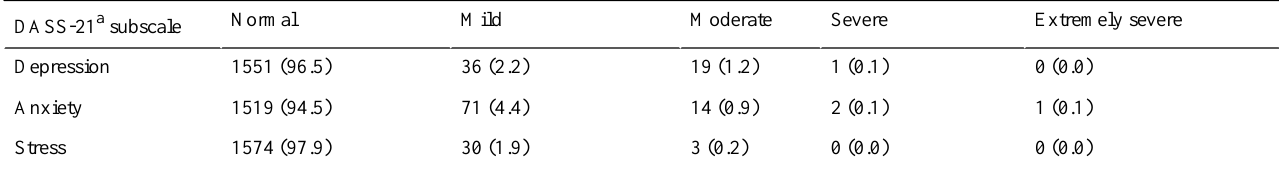
Table 2. Classification of responses to the depression, anxiety, and stress subscales of the DASS-21 (N=1607), n (%).